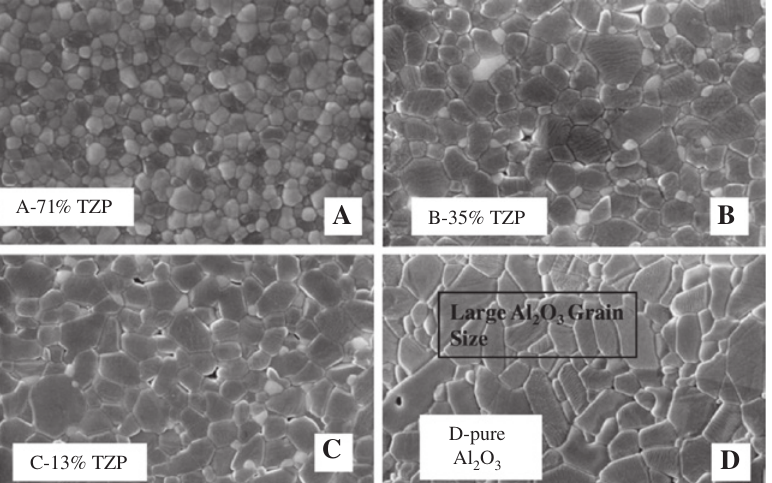
O -Y-TZP graded layer where the dark phase is alumina and the light phase is TZP. (A) Al 2 3 O with 13 vol.% TZP. (D) Pure alumina surface layer. The effect of different percentages of TZP of grain 2 3